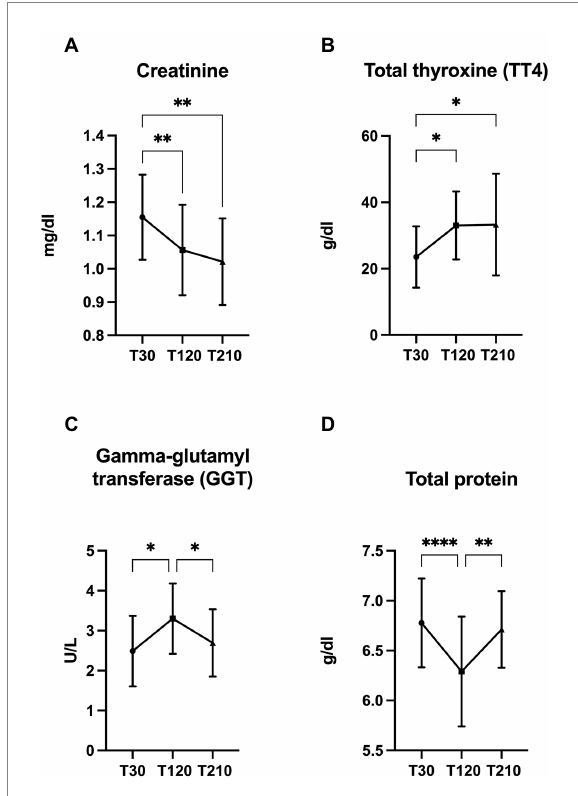
FIGURE 7 Significant changes in the concentration of selected serum metabolites. (A) creatinine, (B) total protein, (C) gamma-glutamyl transferase (GGT), and (D) total thyroxine (TT4) in obese dogs ( n = 16) before (T30), after 90 days (T120), and at the end (T210) of caloric restriction. Significance level: * q < 0.5, ** q < 0.01, **** q <